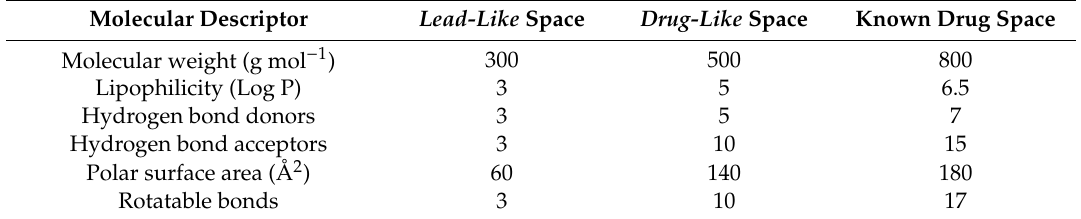
Table 1. Definition of lead-like , drug-like and known drug space (KDS) in terms of molecular descriptors. Molecular Descriptor Lead-Like